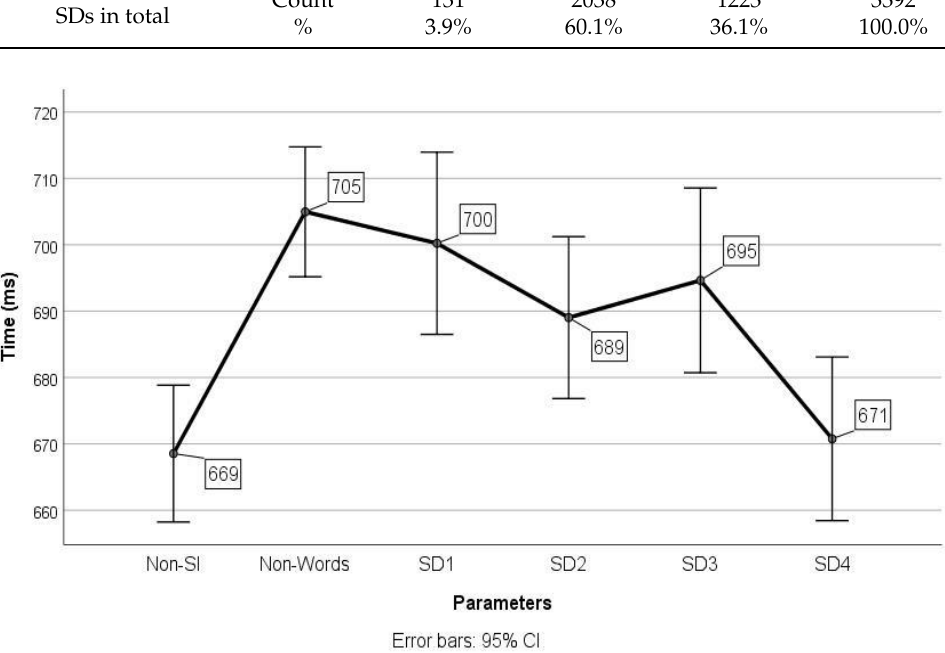
Figure 1. Word recognition time (in ms) depending on the type of stimuli.